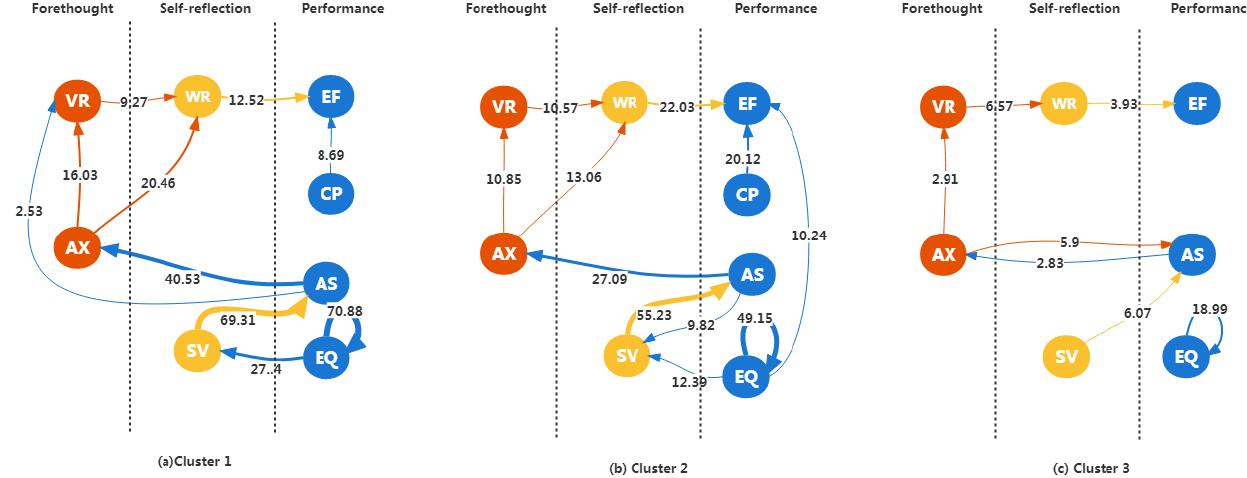
Figure 3. SRL behavior transition diagram of different learning groups. (a. cluster 1 behavior transition diagram; b. cluster 2 behavior transition diagram; c. cluster 3 behavior transition diagram)